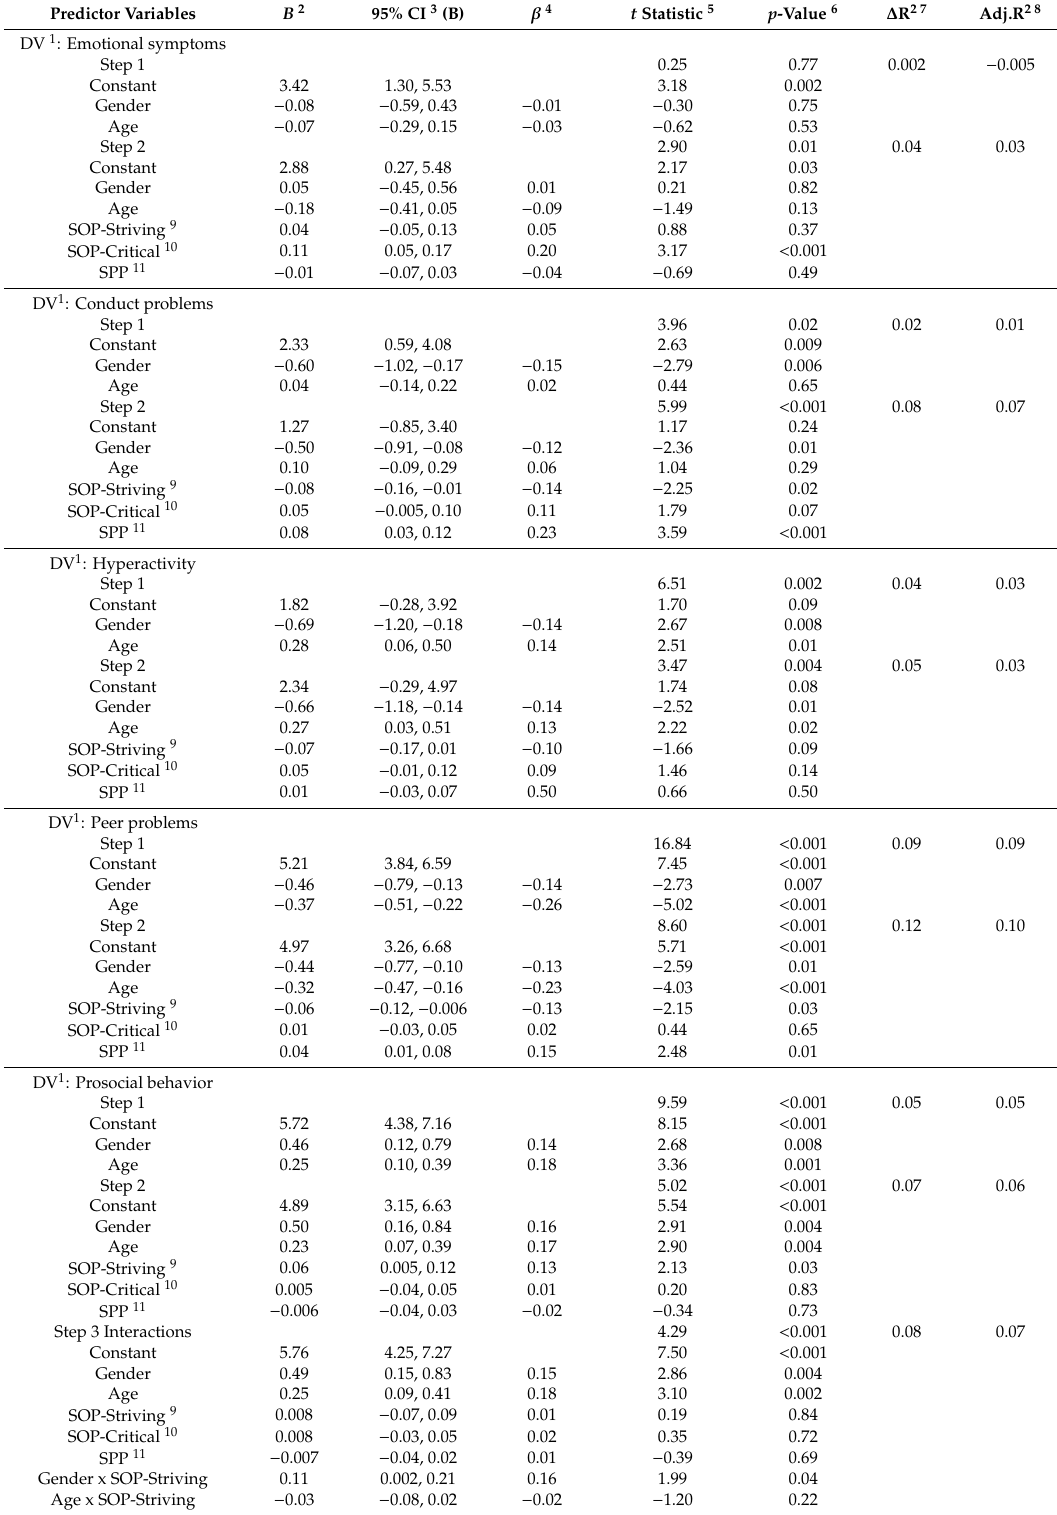
Table 5. Results from hierarchical regression examining the association between perfectionism and symptoms’ emotional symptoms, behavior, hyperactivity, peer problems, and prosocial behavior. Predictor Variables B